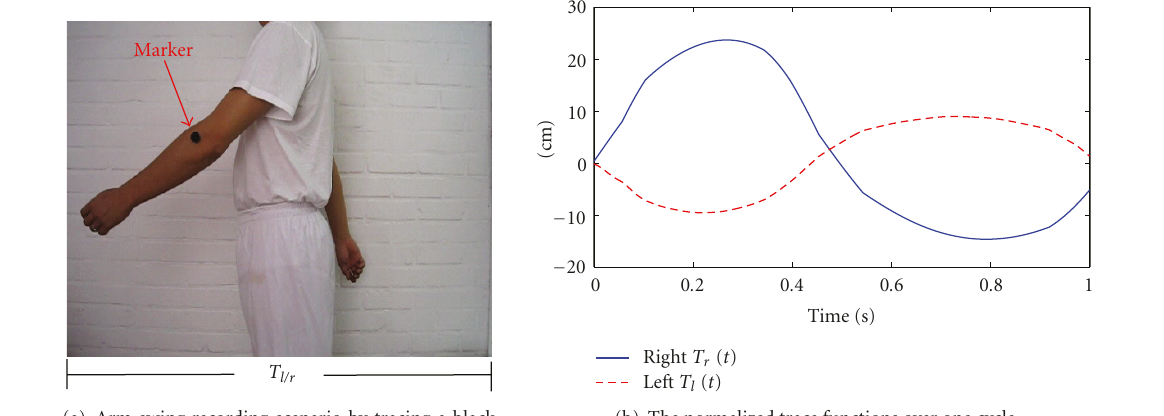
Figure 5: The arm swing modeling.